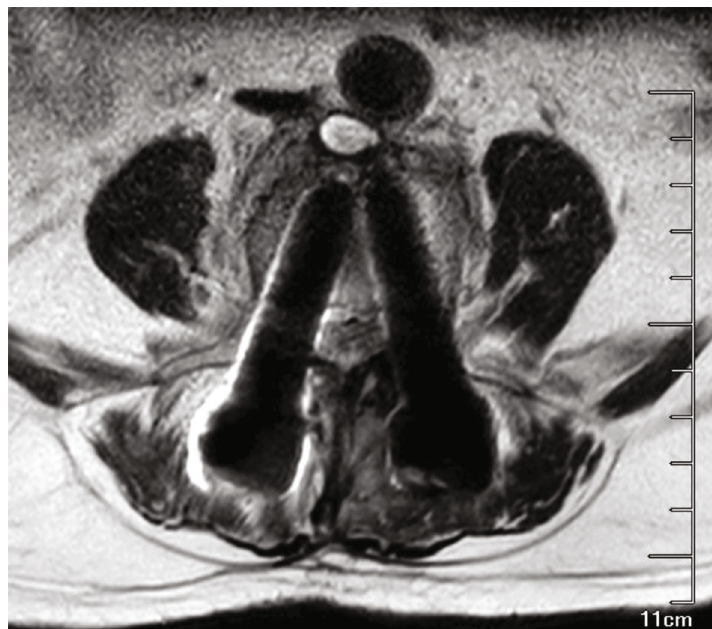
Figure 2: Preoperative MRI of the fourth and fi fth lumbar spine.